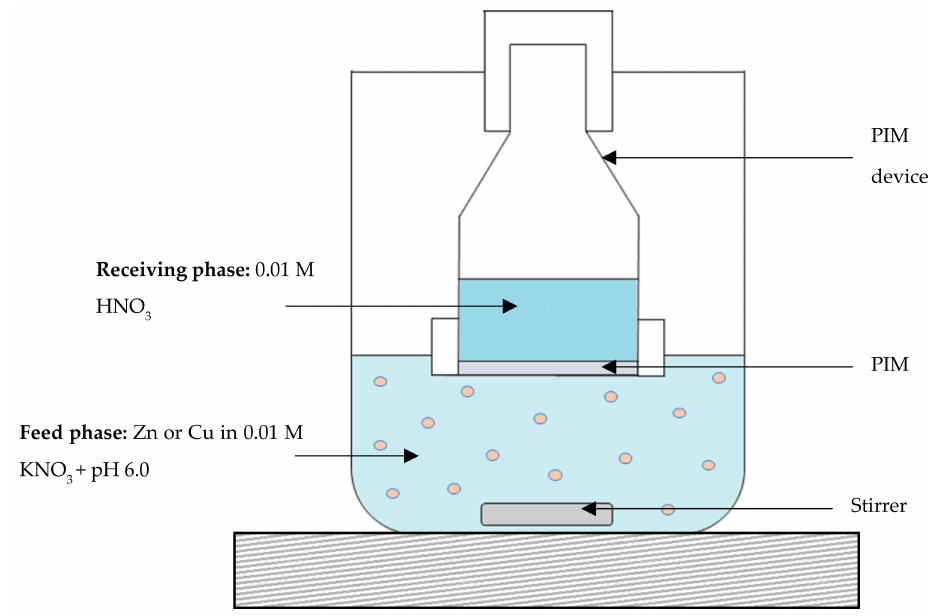
Figure 1. Scheme of the experimental